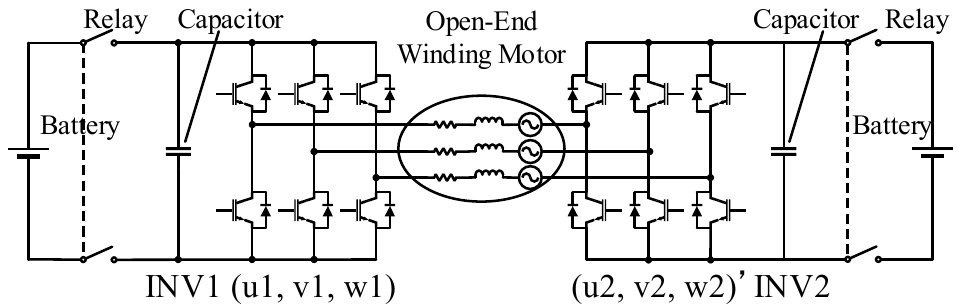
Figure 2. Circuit configuration of dual inverter motor drive.